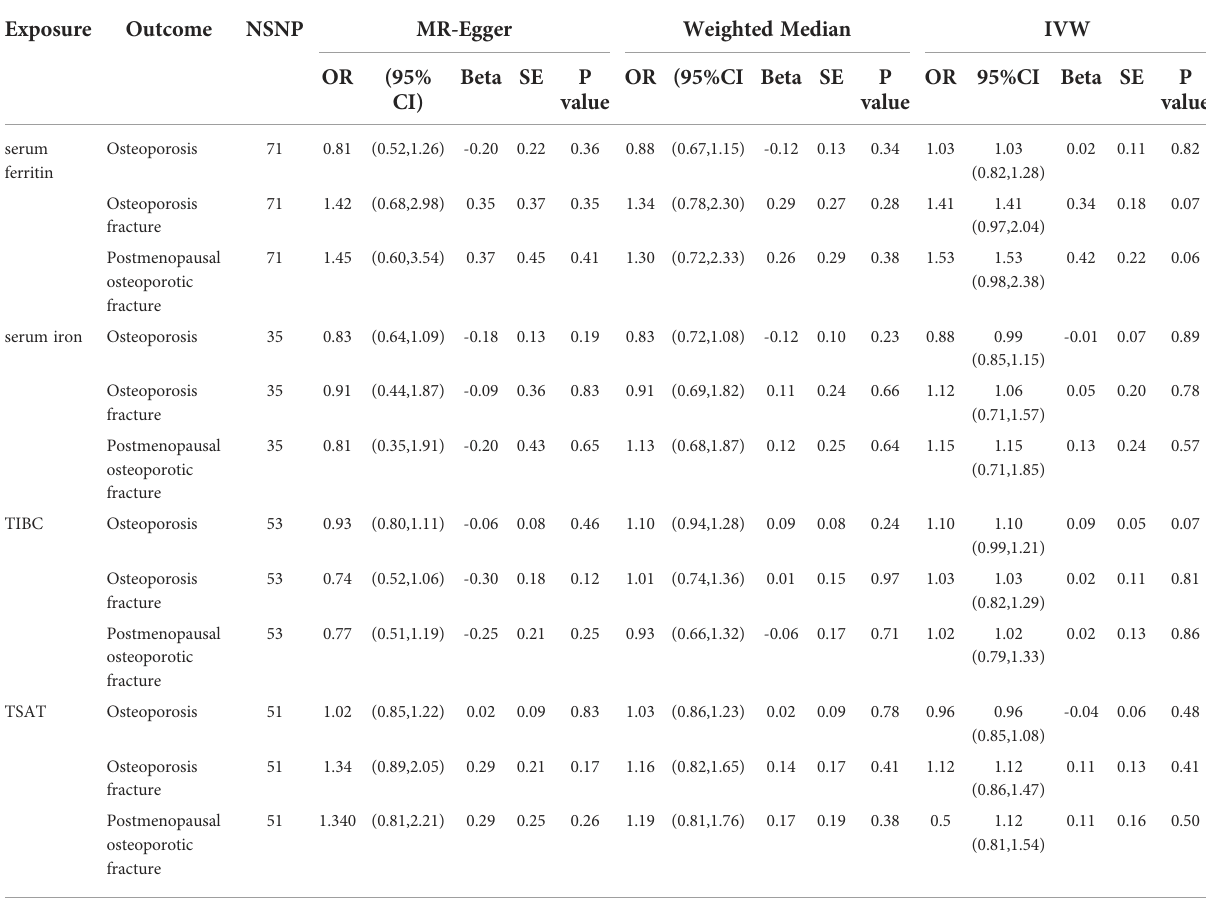
TABLE 1 MR estimates from different methods of assessing the causal effect